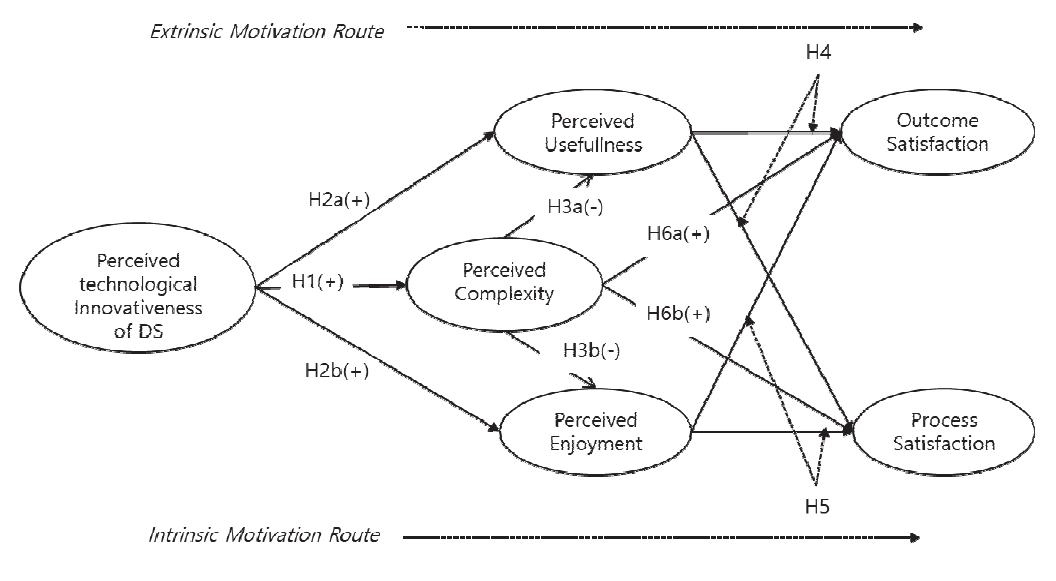
<Figure 1> Proposed Model: Digital Signage User Satisfaction